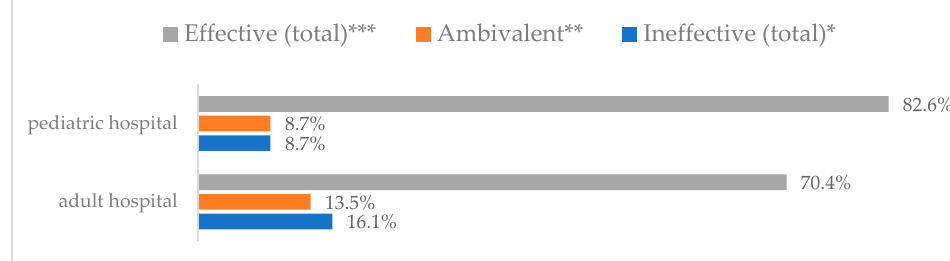
Figure 17. Avoiding contact with sick people to prevent influenza virus infection by age ( N = 905). *Sum of responses: completely ineffective, ineffective, rather ineffective; **Response: neither inef- fective nor effective; ***Sum of responses: rather effective, effective, completely effective.